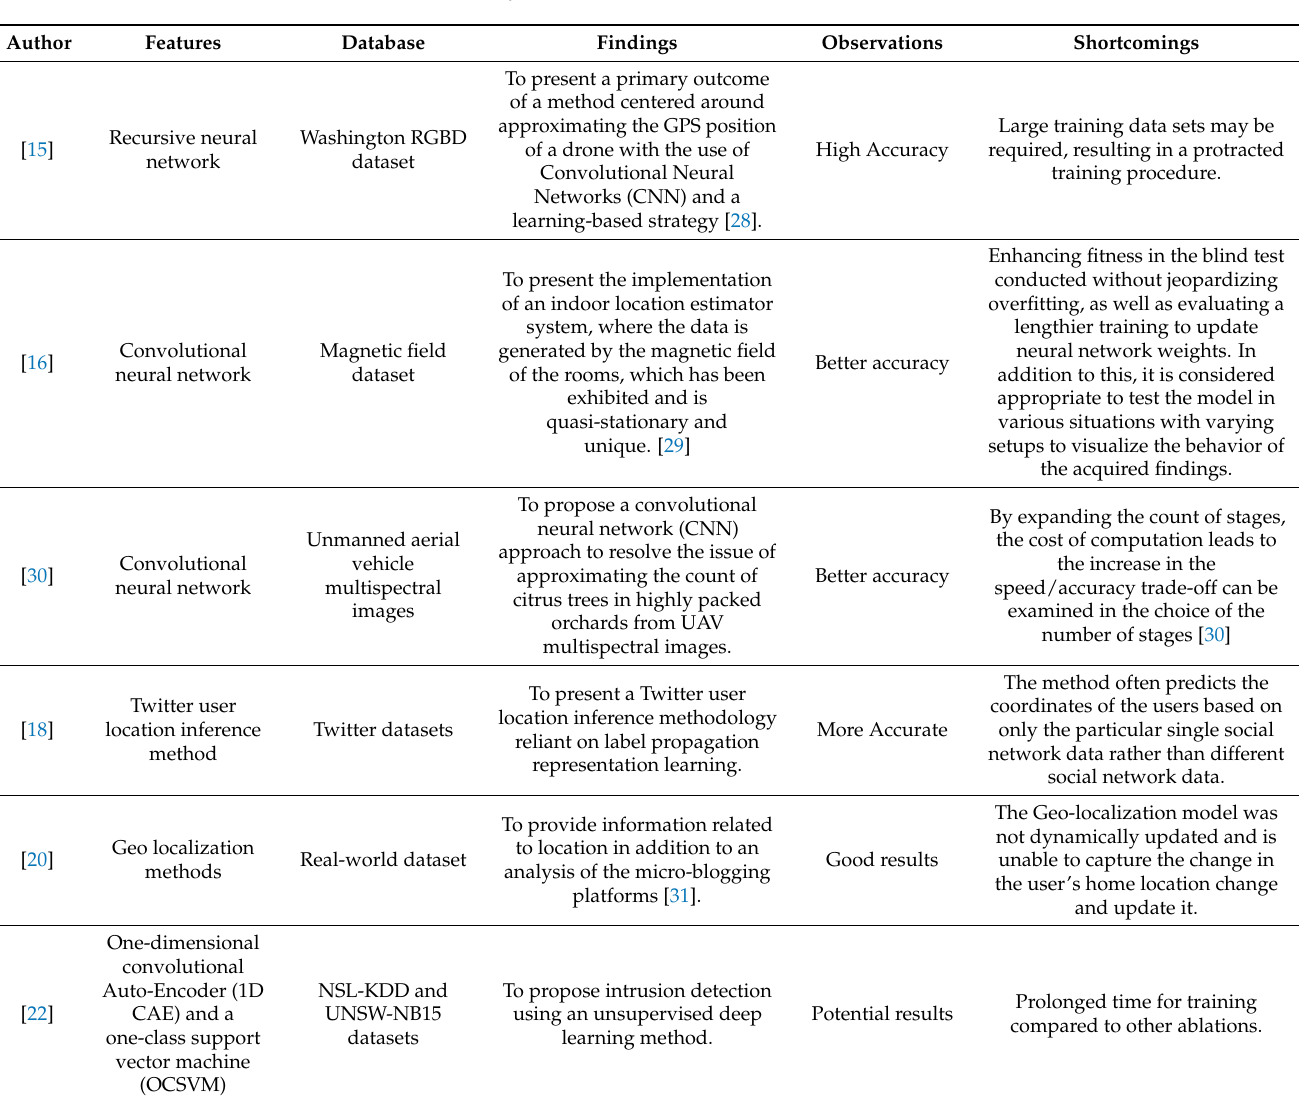
Table 2. A summary of the most relevant related